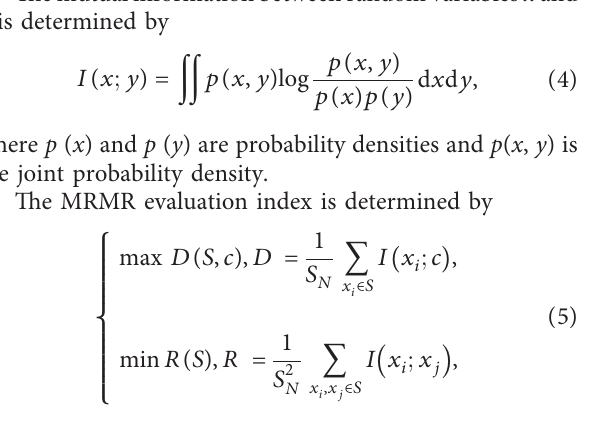
Algorithm. The maximum relevance minimum